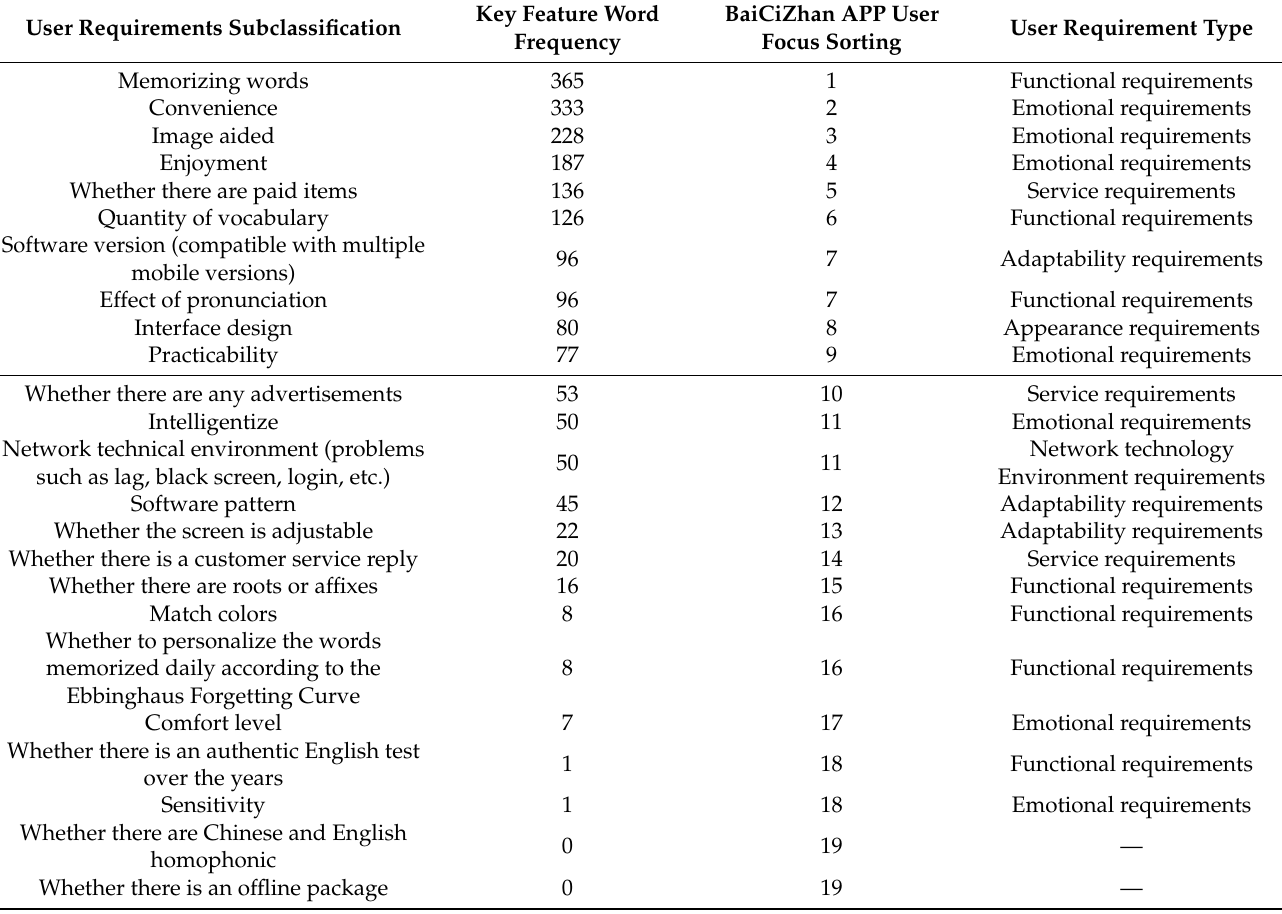
Table 8. BaiCiZhan user requirement elements